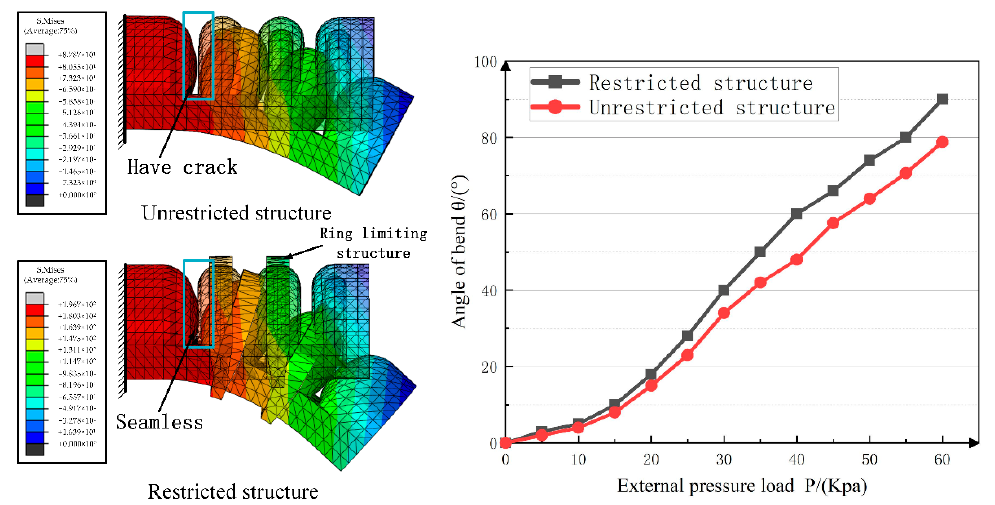
Figure 9. Thumb base joint simulation.